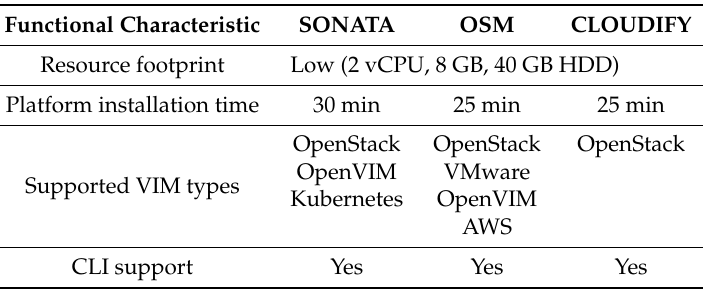
Table 4. Comparison of functional